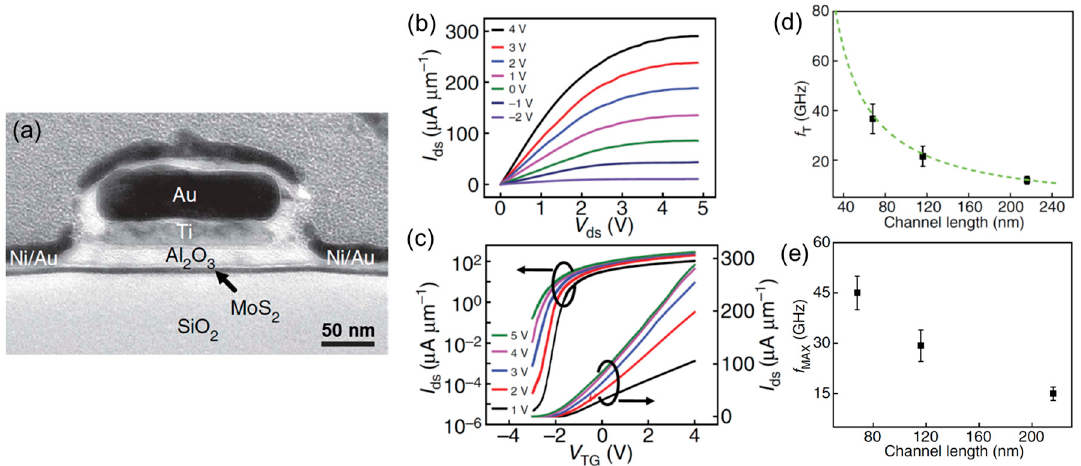
Figure 2. Cross-sectional TEM micrograph ( a ); DC output ( b ) and transfer ( c ) characteristics of an FET fabricated with multilayer MoS 2 . Scaling behavior of f T ( d ) and f MAX ( e ) with the channel length. Figures adapted with permission from [47].